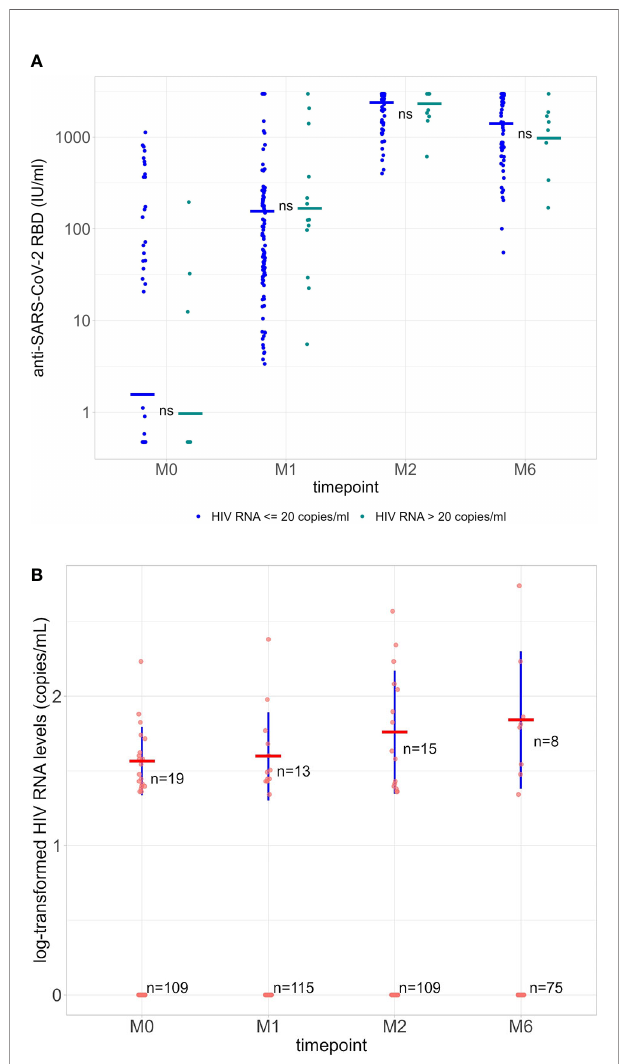
FIGURE 3 | (A) Quanti fi cation of anti-RBD Ig (GMT) in HIV-1 undetectable patients ( ≤ 20 copies/ml, blue dots) and HIV-1 detectable patients (>20 copies/ml, green dots) at each time point. ns = not signi fi cant (P-value >0.05). (B) Log-transformed values of HIV-1 RNA levels at each time point. Average values (red) and standard deviations (blue) were calculated only using detectable HIV-1 RNA levels (>20 copies/ml). Differences are not statistically signi fi cant (P>0.05). RBD, receptor binding domain; GMT, geometric mean titers; M0, at the fi rst dose; M1, 30 days after the fi rst vaccine dose; M2, 60 days after the fi rst vaccine dose; M6, 6 months after the fi rst vaccine dose.